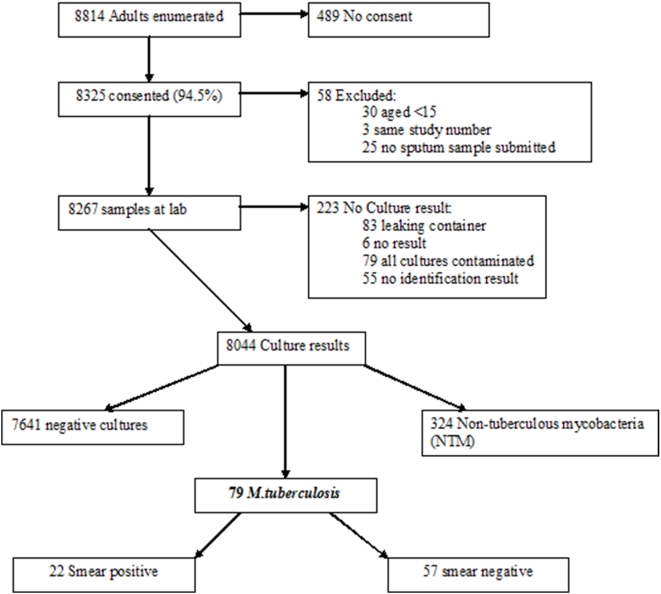
Flowchart of Individuals within the Study.